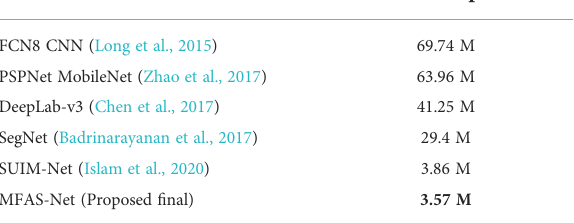
TABLE 6 Comparison between other methods and MFAS-Net ’ s trainable parameters requirement.